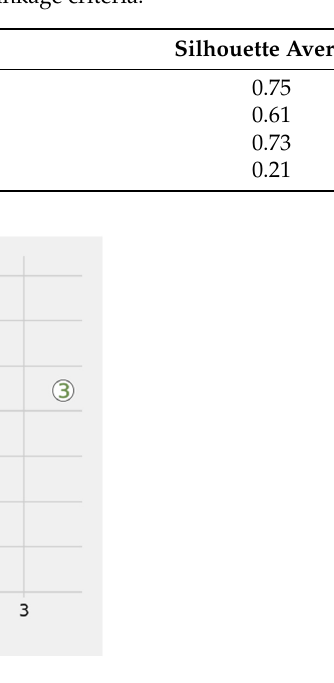
10 of 13 Table 1. Silhouette average score for different linkage criteria. Linkage Criteria